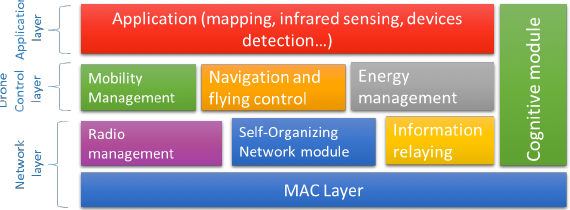
Figure 2. Detection cycle